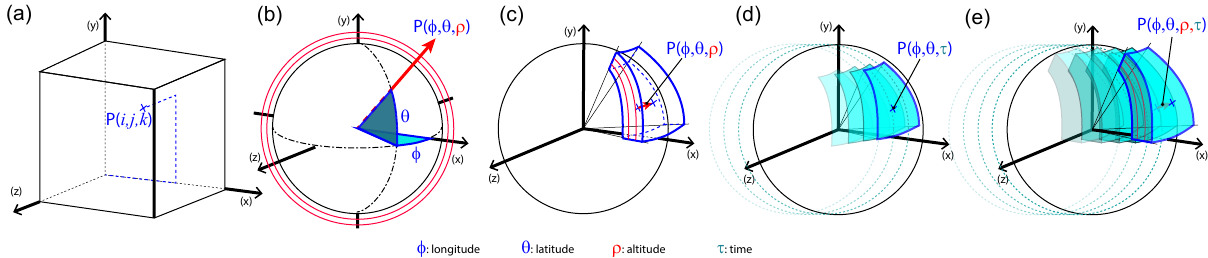
Figure 1. Actual representation of possible datacubes: (a) 3D Cartesian ( x, y, z ) datacube; (b) spherical ( ϕ, θ, ρ ) datacube with ρ constant; (c) partial multi-layer spherical ( ϕ, θ, ρ ) datacube with ρ as a variable; (d) time-related partial spherical ( ϕ, θ, t ) datacube; (e) time-related partial multi-layer spherical ( ϕ, θ, ρ, t ) datacube.